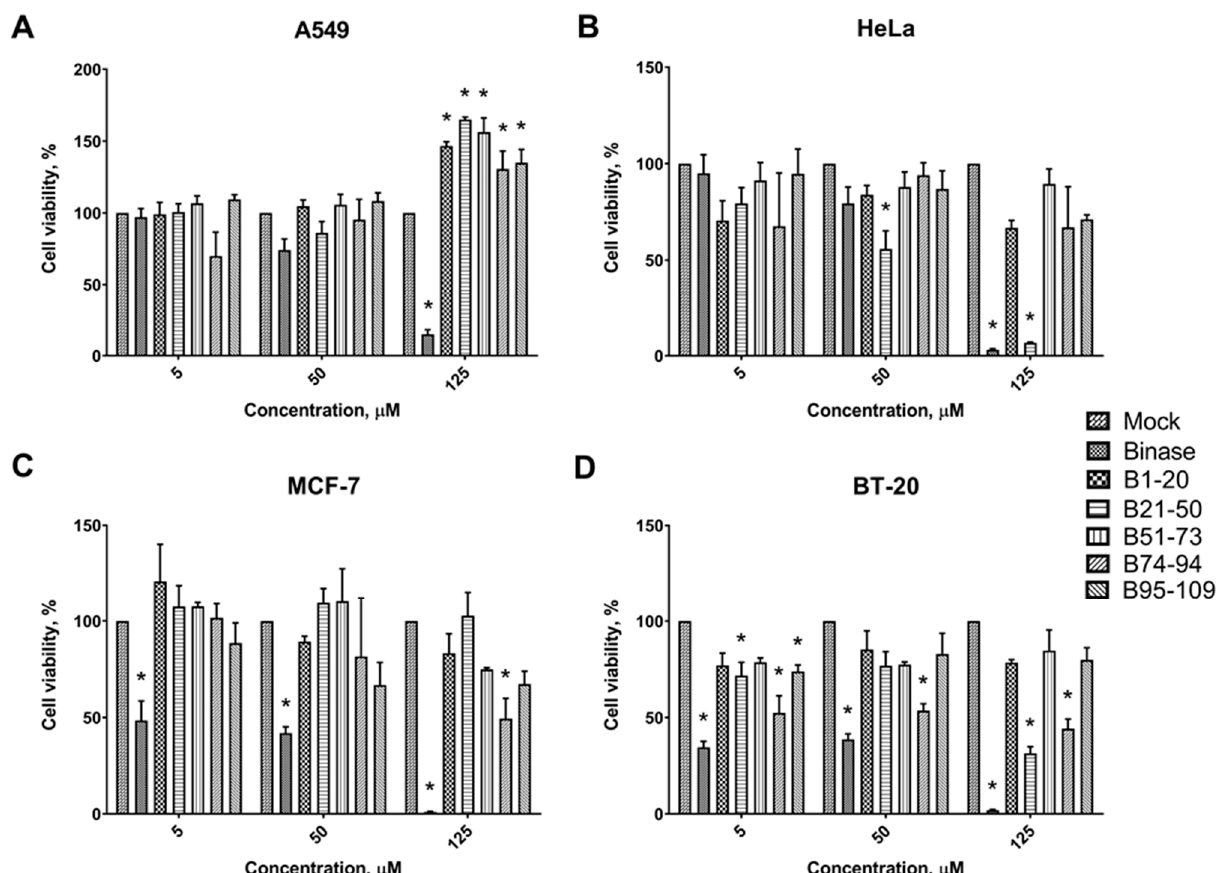
Figure 2. The effect of binase and binase-derived peptides on the cell viability of the A549 cells ( A ), the HeLa cells ( B ), the MCF-7 cells ( C ), and the BT-20 cells ( D ) as measured via the MTT (3-(4,5-dimethylthiazol-2-yl)-2,5-diphenyltetrazolium bromide) assay. Cells were incubated with the indicated concentrations of the compounds for 48 h. The viability of untreated cells was taken for 100%. Data are representative of three independent experiments; * p < 0.0001 as determined by two-way ANOVA with Dunnett’s post-hoc test for multiple comparisons.